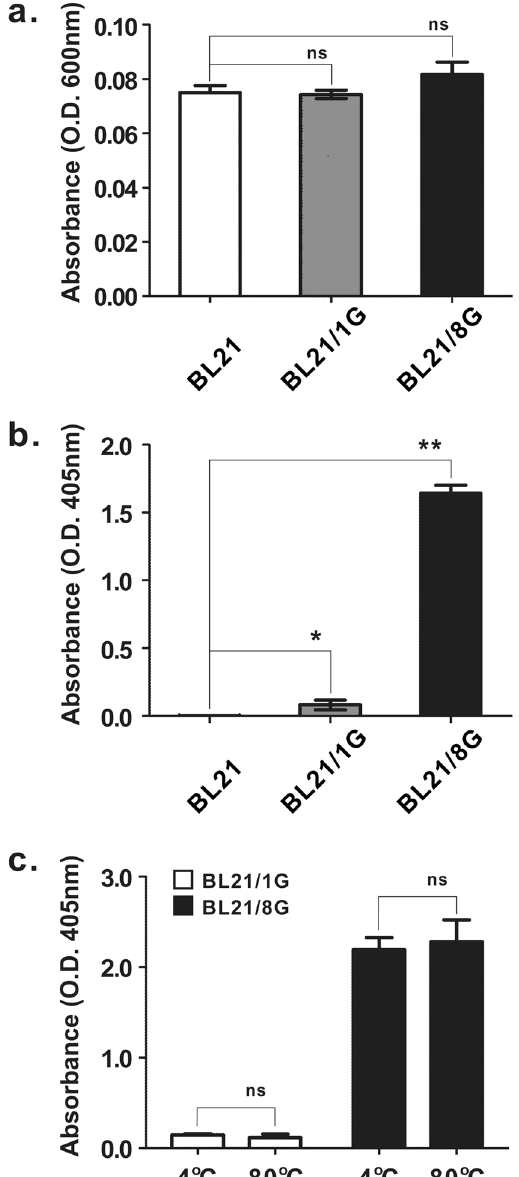
Figure 4. The antibody-trapping ability of poly-protein G-expressing bacteria. ( a ) Equivalent amounts of BL21, BL21/1G and BL21/8G cells were coated on 96-well plates. The absorbance of the bacteria was measured at 600 nm. ( b ) The antibody-trapping ability of BL21, BL21/1G and BL21/8G cells coated on 96-well plates was analyzed by HRP-conjugated goat antibody. Statistical analysis was performed by one-way ANOVA. ( c ) BL21/1G and BL21/8G cells were preserved in PBS containing 30% (v/v) glycerol at indicated temperatures for 40 days. The antibody-trapping ability of these bacteria was analyzed by HRP-conjugated goat antibody. Statistical analysis was performed by two-way ANOVA. Bar, SD. ns, no significant difference. * P value < 0.05; ** P value <